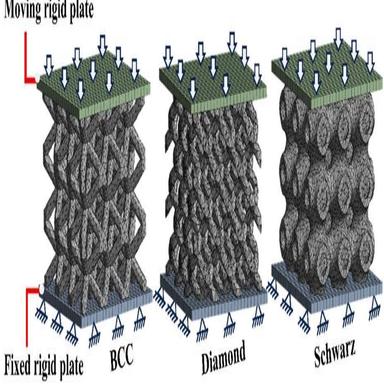
Meshing and boundary conditions of the FEM of the lattice structures.